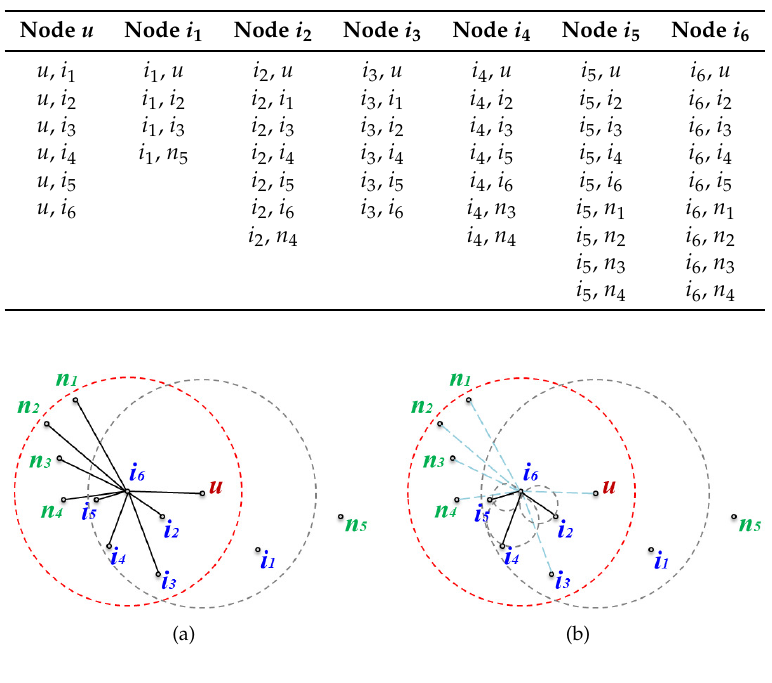
Figure 4. Local graphs of node i 6 : ( a ) the local network graph; and ( b ) the local Gabriel graph (GG).